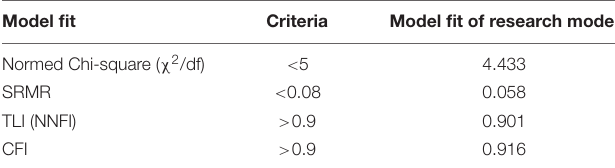
TABLE 4 | Model fit criteria and the test